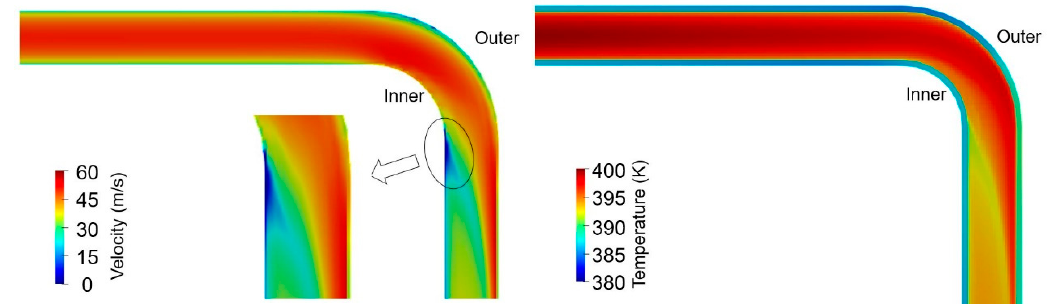
Figure 12. Streamwise velocity magnitude and temperature contours of horizontal section along center axis of curved pipe.